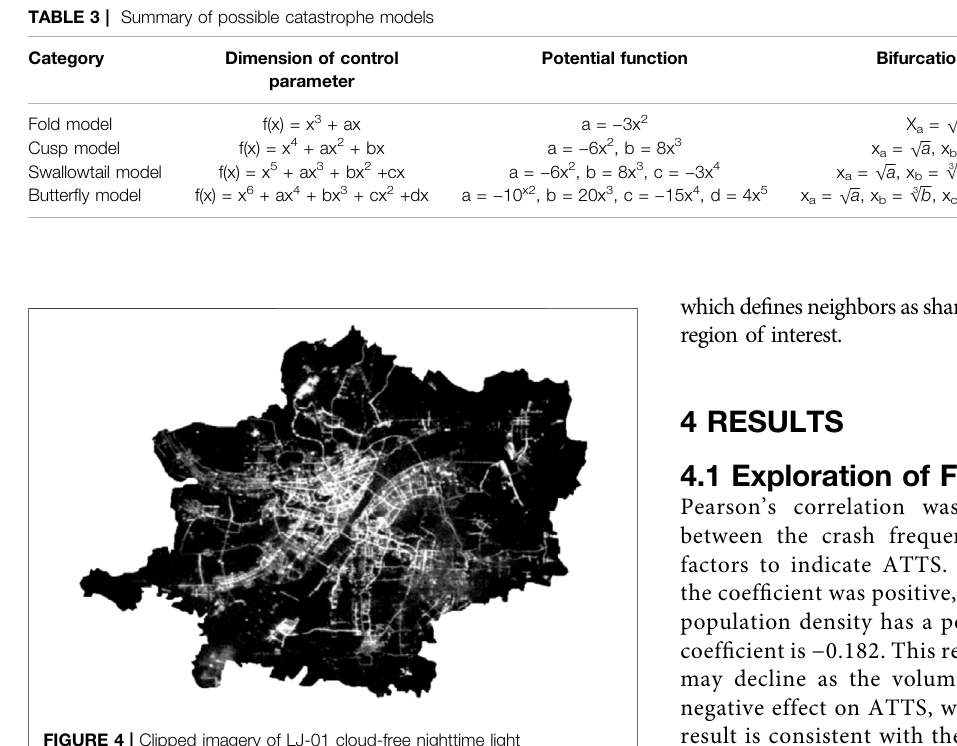
FIGURE 4 | Clipped imagery of LJ-01 cloud-free nighttime light imagery data.